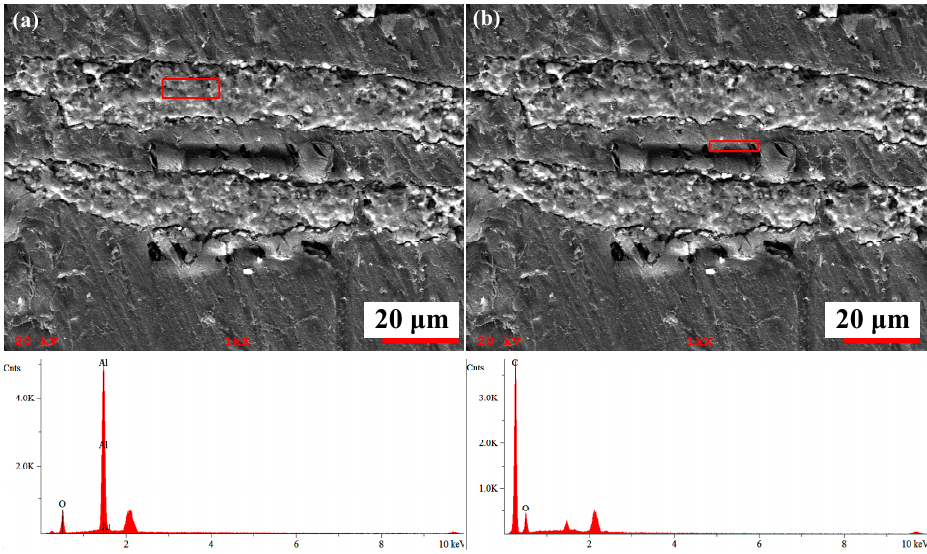
Figure 3. EDS (Energy Dispersive Spectrometer) analysis of laminated Al 2 O 3 /PMMA composites: ( a ) Al 2 O 3 region; ( b ) PMMA region.